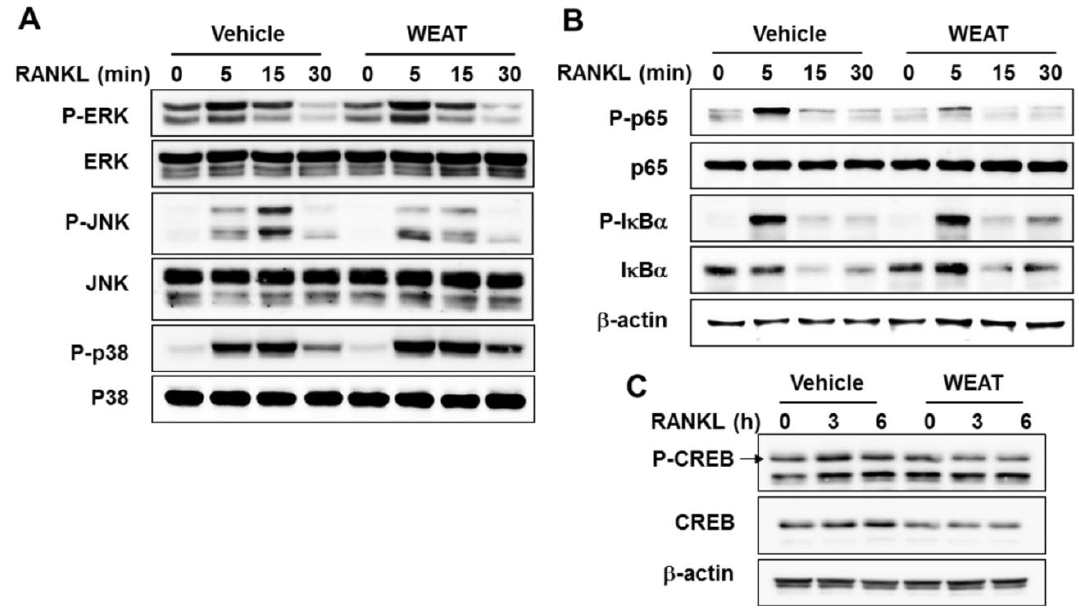
Figure 3. Effect of WEAT on RANKL-Induced MAP kinase, NF-κB, and CREB activation in BMMs. ( A – C ) BMMs were pretreated with WEAT (50 μg/mL) for 3 h and then stimulated with RANKL (100 ng/mL) for the indicated times. The total and phosphorylated levels of the indicated proteins were determined by western blot